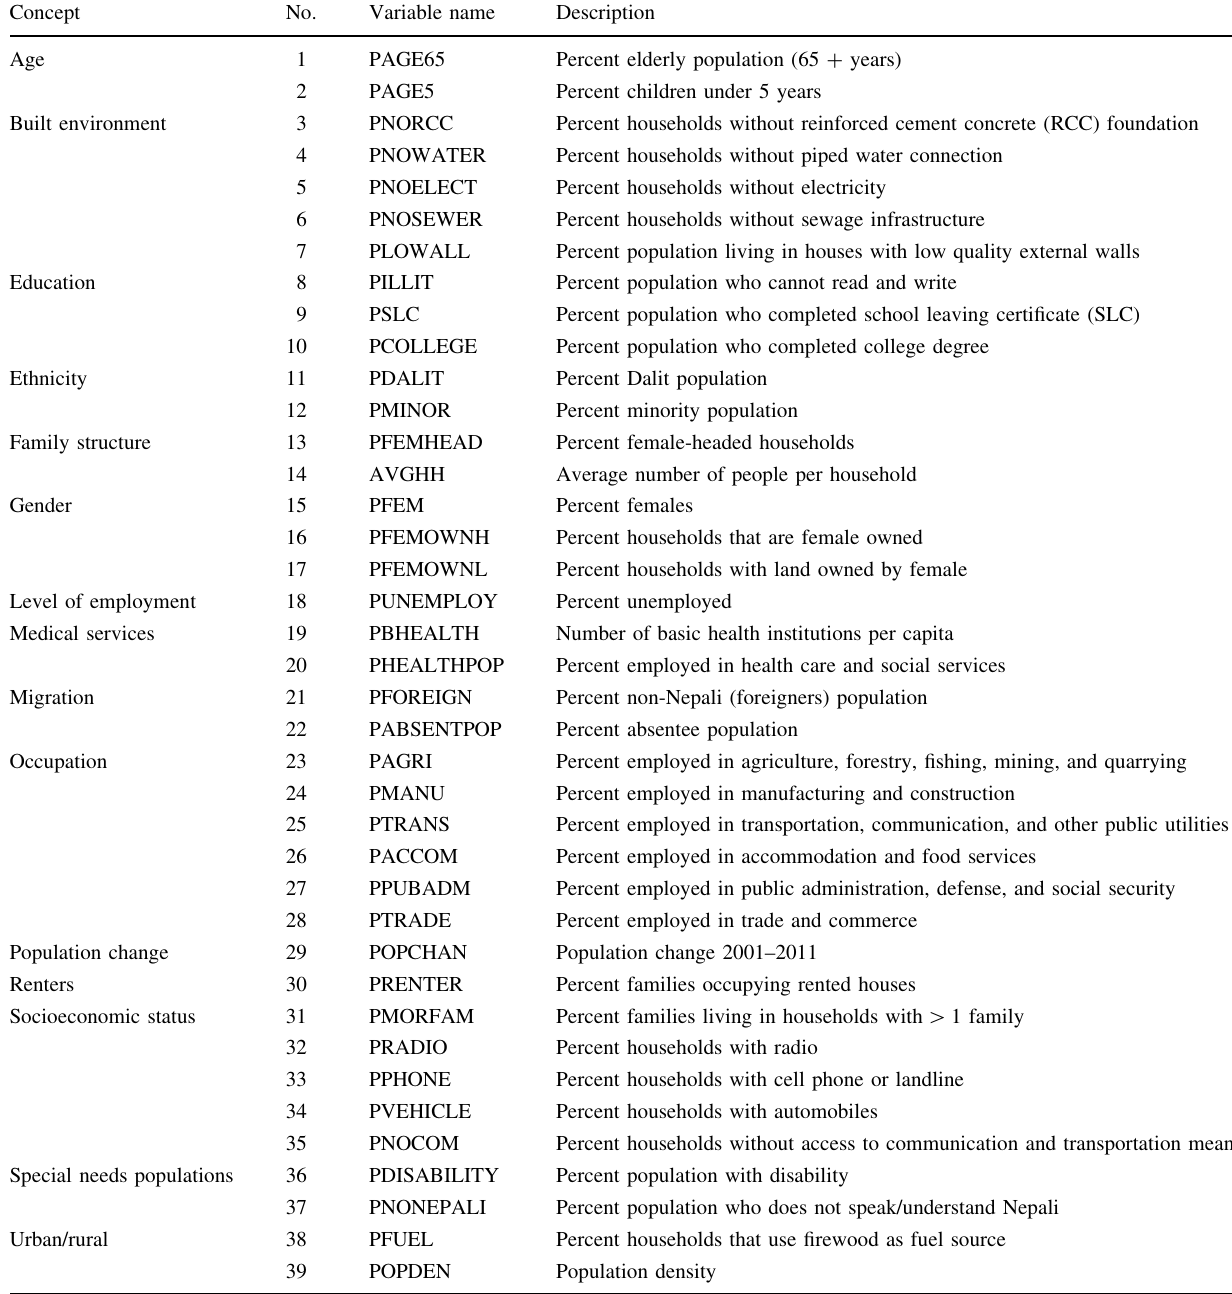
Table 1 Concepts and variables used to construct the modified Social Vulnerability Index for Nepal